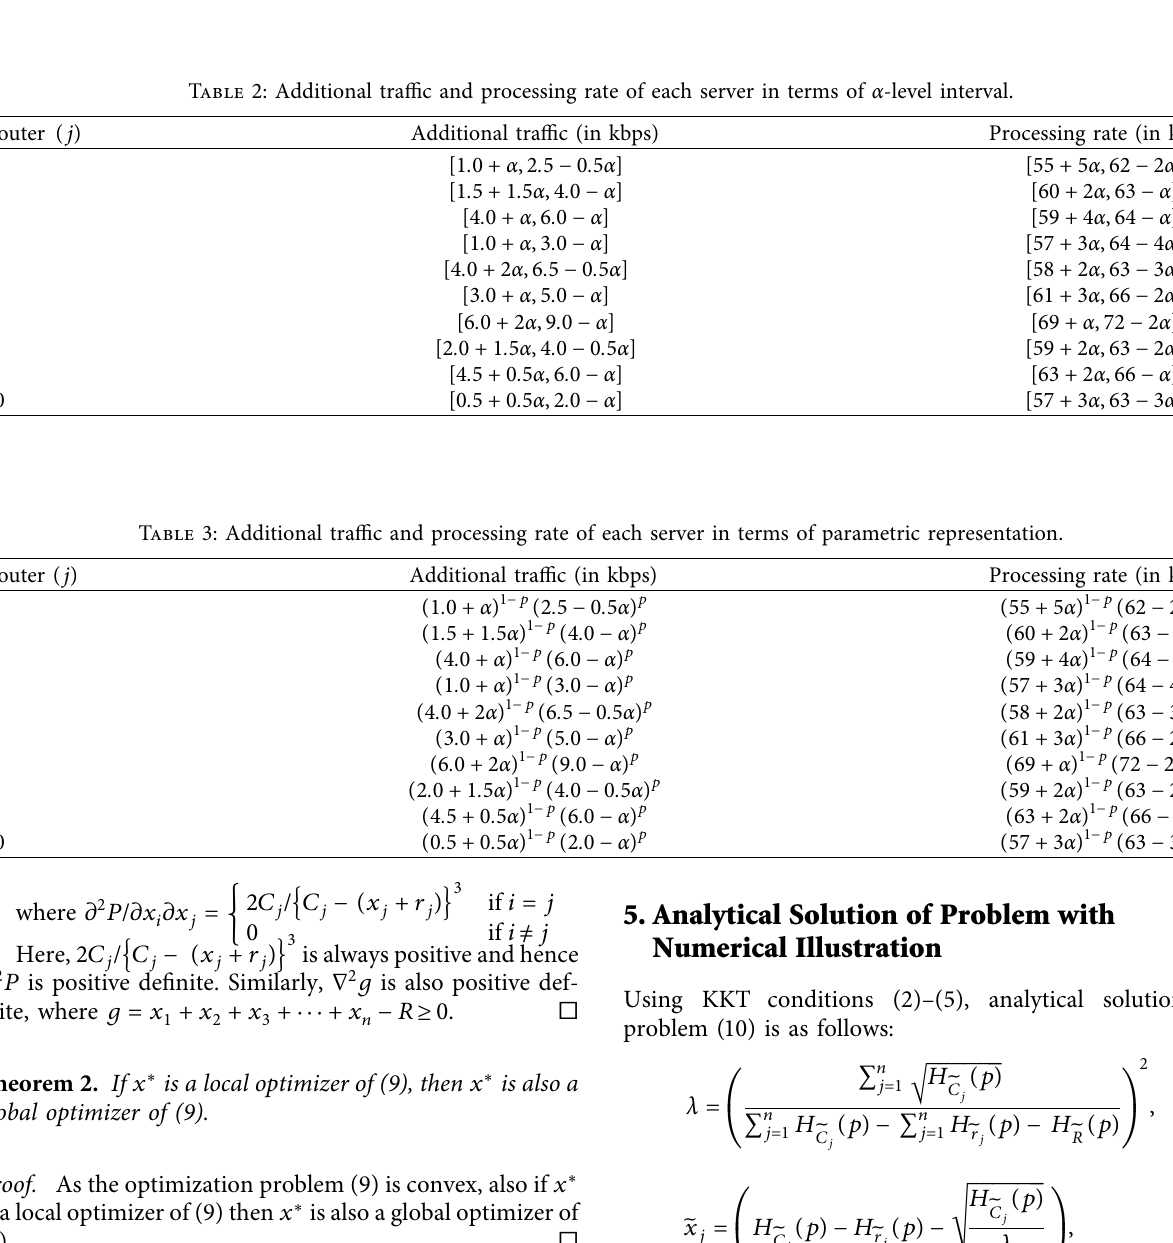
Table 1: Additional traffic ( 􏽥 r